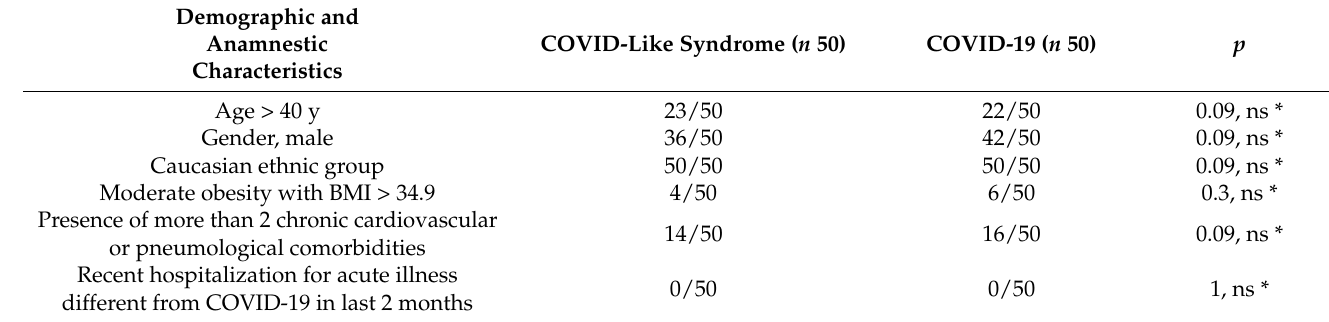
Table 2. Clinical and demographic anamnestic characteristics of analyzed